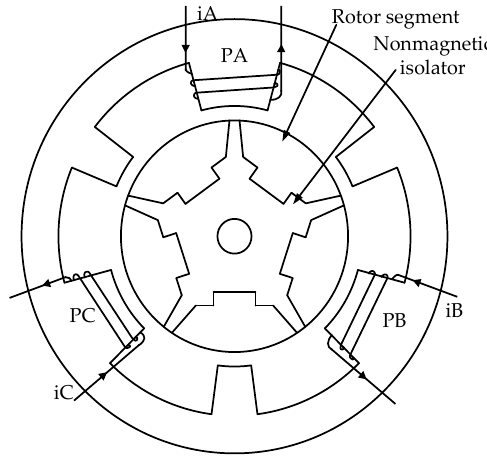
Figure 11. The structure of the segmented stator SRM [40].